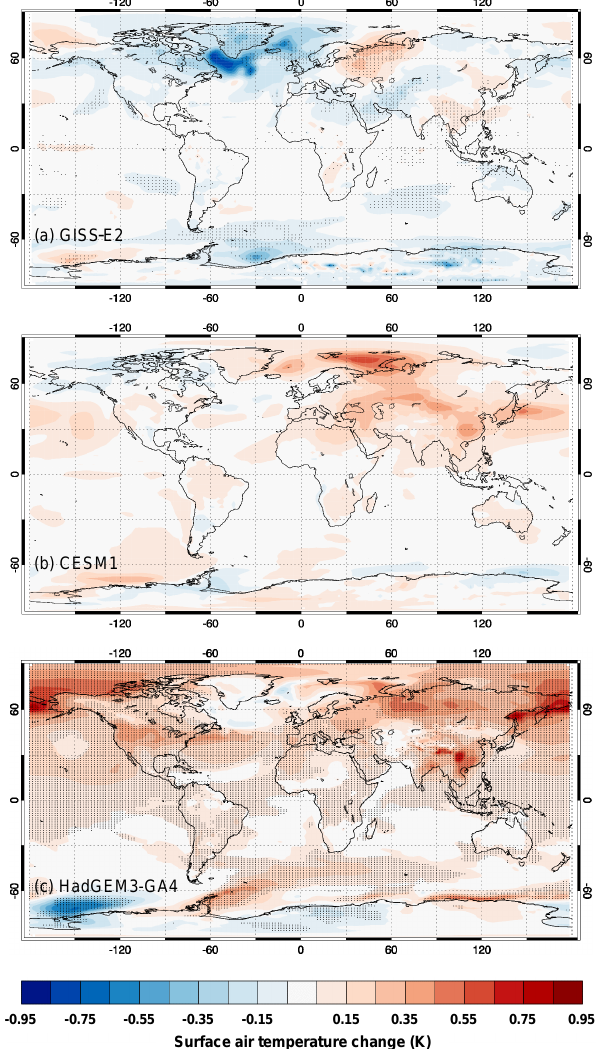
Figure 2. Global changes in surface air temperature due to remov- ing anthropogenic SO 2 emissions from China for (a) GISS-E2, (b) CESM1, and (c) HadGEM3. Differences are for 150-year an- nual means of perturbation simulation minus control simulation. Stippling for GISS-E2 and HadGEM3-GA4 indicates changes ex- ceeded 2 standard deviations for that grid